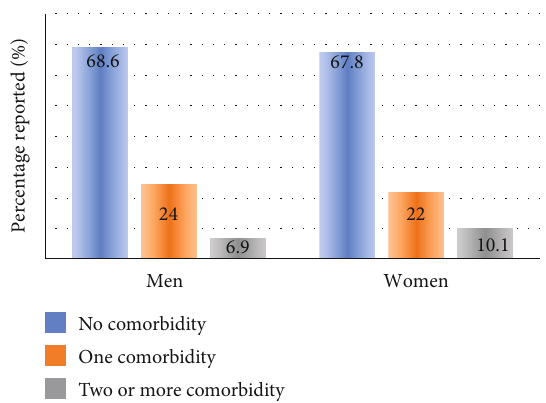
Figure 6: Number of comorbidities by